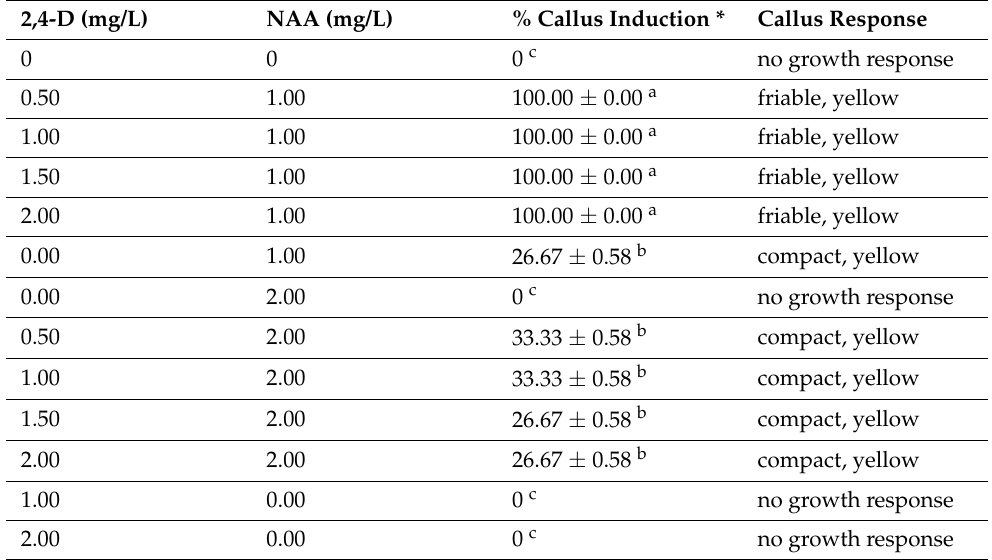
Figure 1. Rhinacanthus nasutus (L.) Kurz—A Thai medicinal plant used in the present study: ( A ) a mature plant, ( B ) a shoot tip, and ( C ) a flower. Table 1. The effects of different combinations of plant growth regulators on callus induction in R. nasutus .